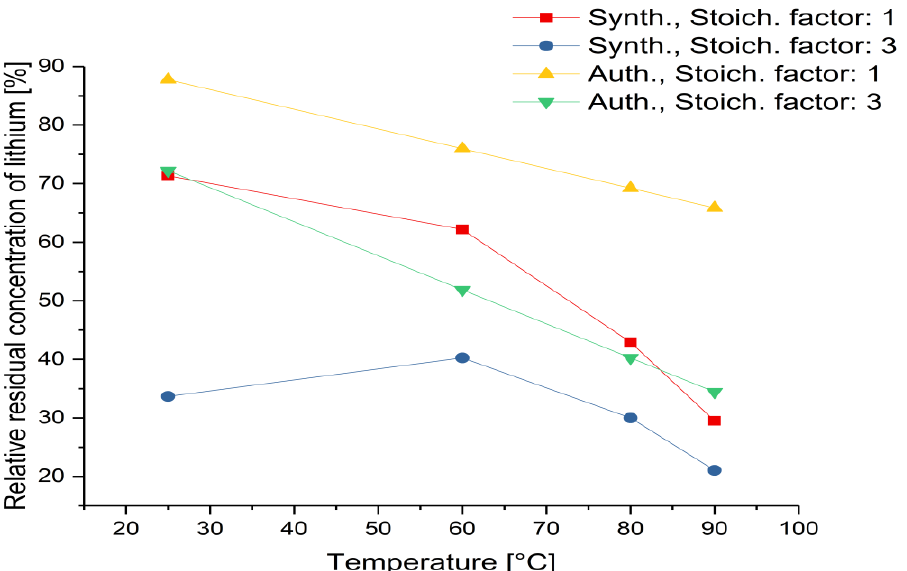
Figure 3. Relative residual concentration of lithium in the samples as a function of temperature and stoichiometric factor (interaction plot of the model) based on the synthetic and authentic leaching solution for the precipitation with K 2 HPO 4 .